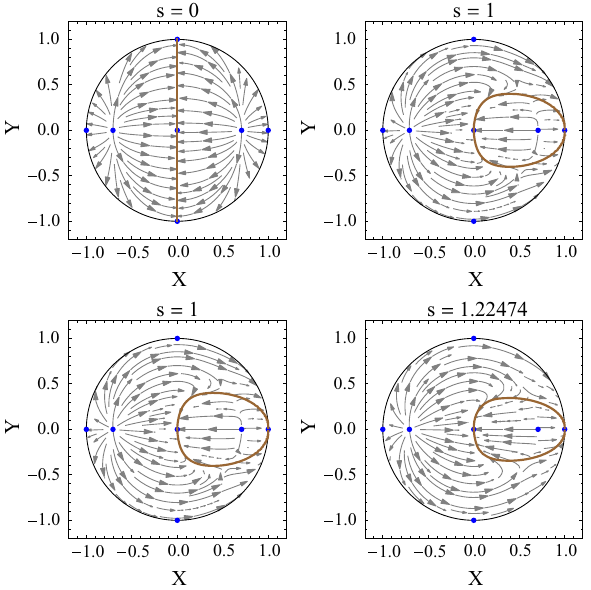
Fig. 14 Compactphaseportraitofthesystem(323),(324),fordifferent choices of the parameter